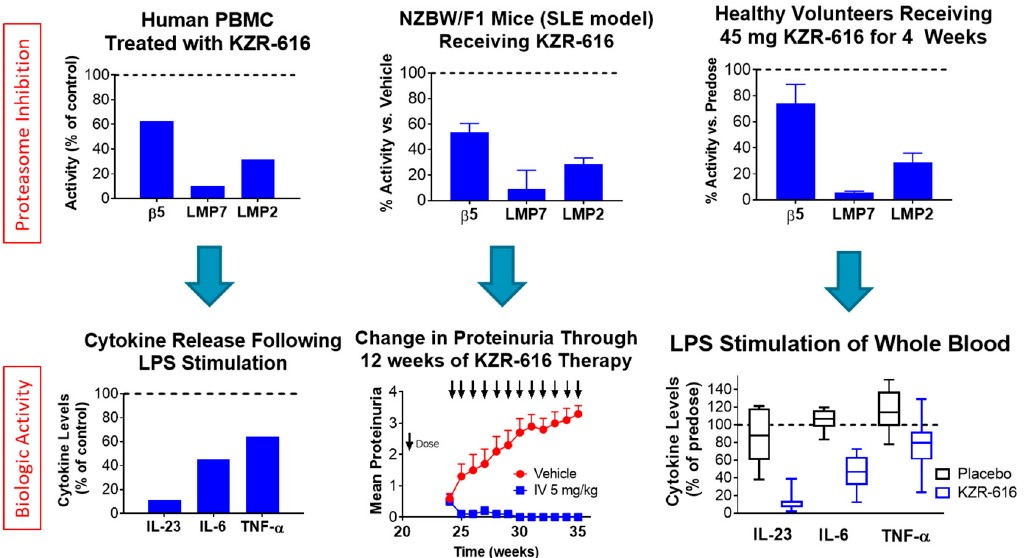
Figure 3. Comparison of Proteasome Subunit Inhibition and Biologic Activity in Preclinical Models to Clinical Pharmacodynamics and Biomarker Activity. Upper panels represent inhibition of selected proteasome subunits following in vitro exposure or single-dose administration to mice or healthy volunteers. Bottom panels represent readouts of cytokine release from endotoxin stimulation of human PBMC in vitro, proteinuria levels in NZB/W F1 mice, and ex vivo stimulation of whole blood and cytokine measurements in healthy volunteers. Data adapted from